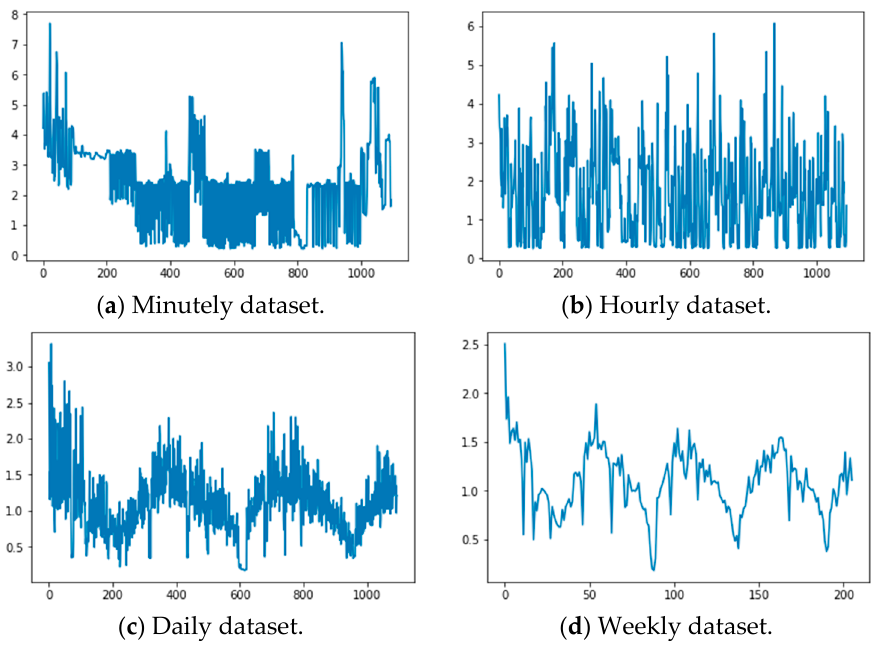
Figure 1. Samples of four electrical energy consumption datasets.